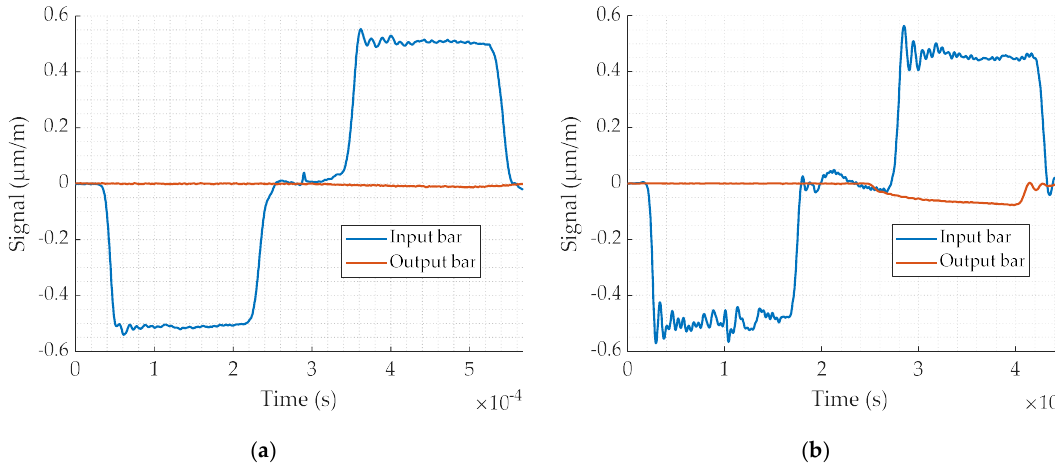
Figure 10. Input and output signals obtained by experimental testing for: ( a ) Setup 1; ( b ) Setup 4.